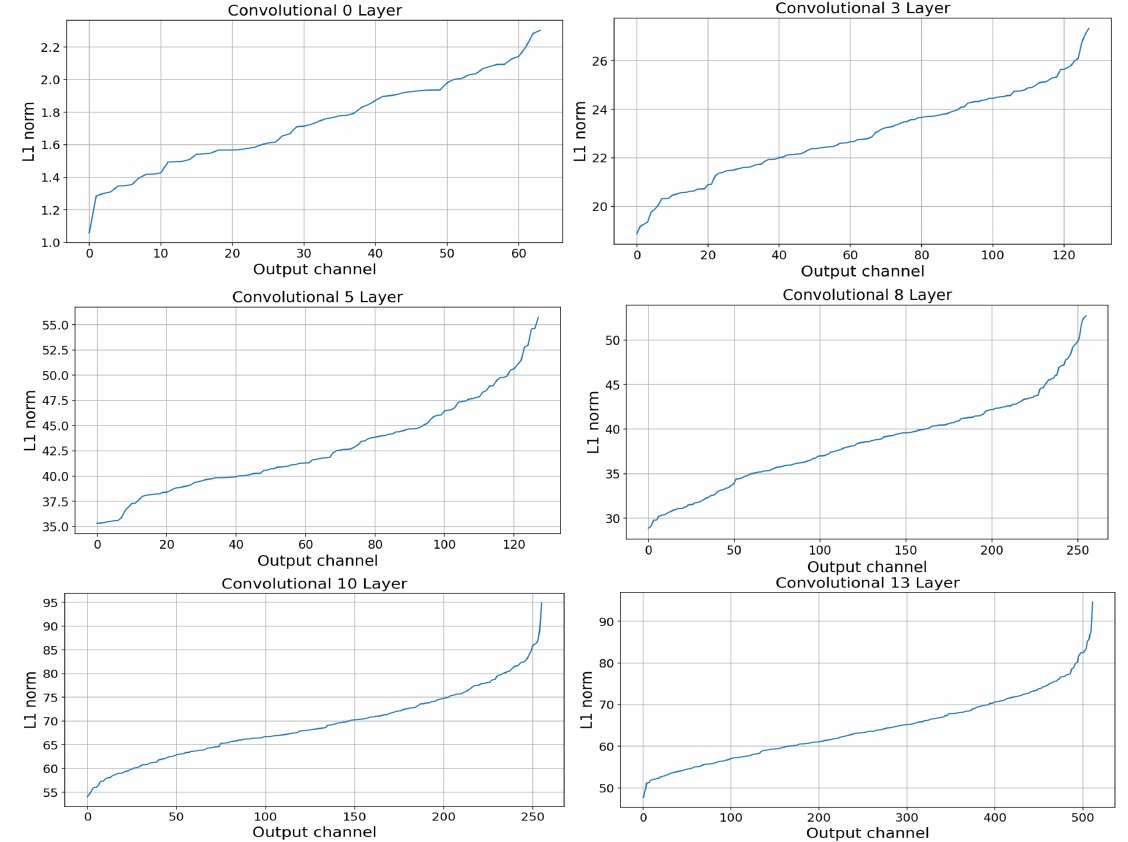
Figure 11. Filters of the first six layers of the proposed convolutional neural network, ranked by weight l1 normalization.